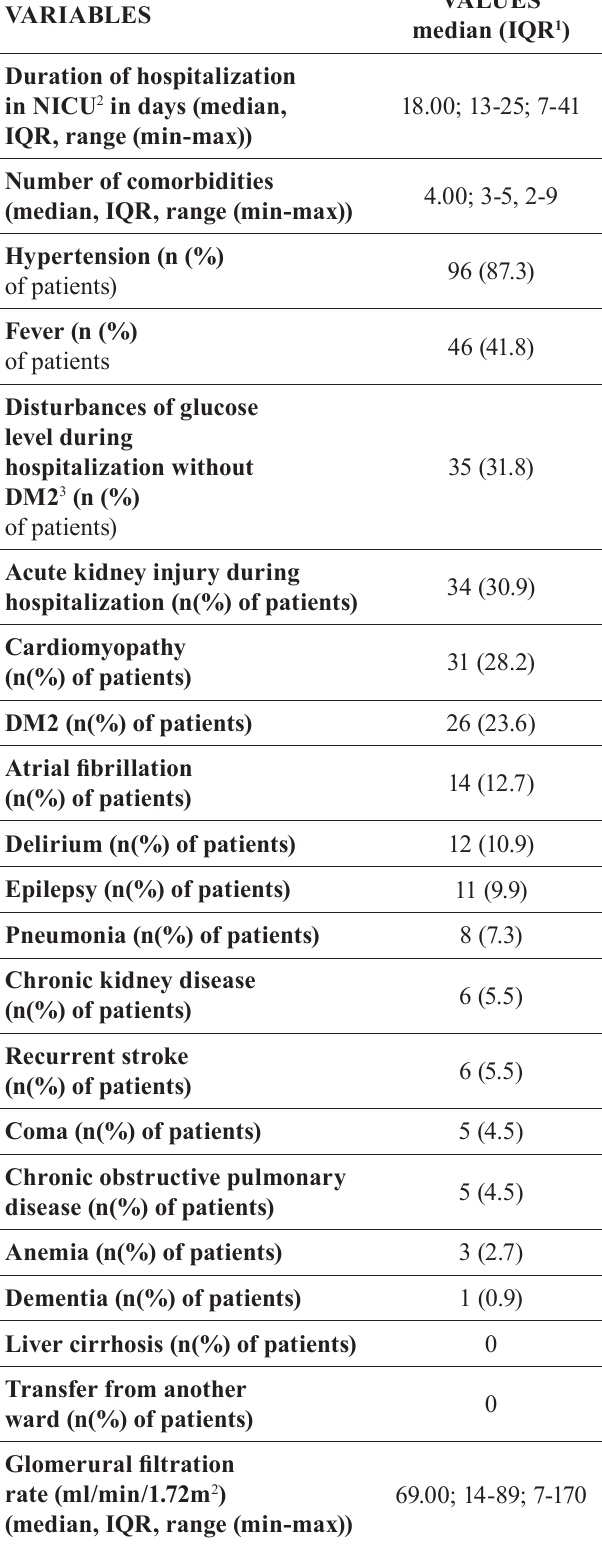
TABLE I - C linical characteristics of patients with sICH